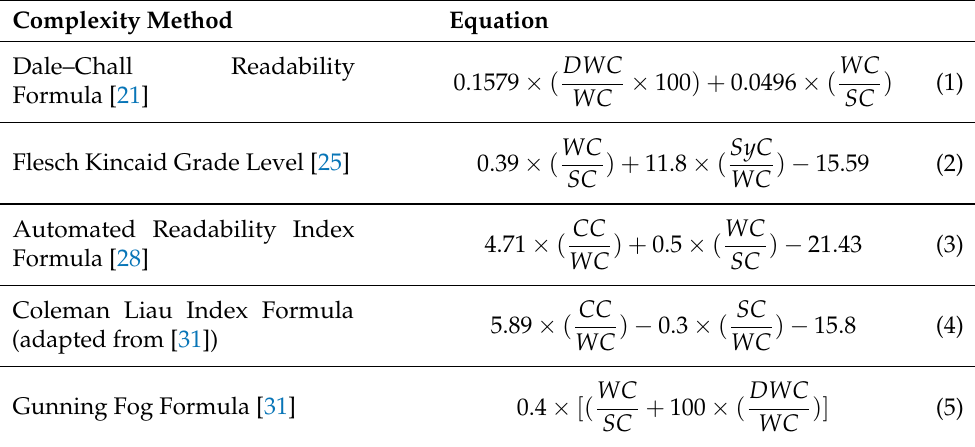
Table 1. Readability metrics. WC = Word Count, DWC = Difficult or Complex Word Count, SC = Sentence Count, SyC = Syllable Count, CC = Character